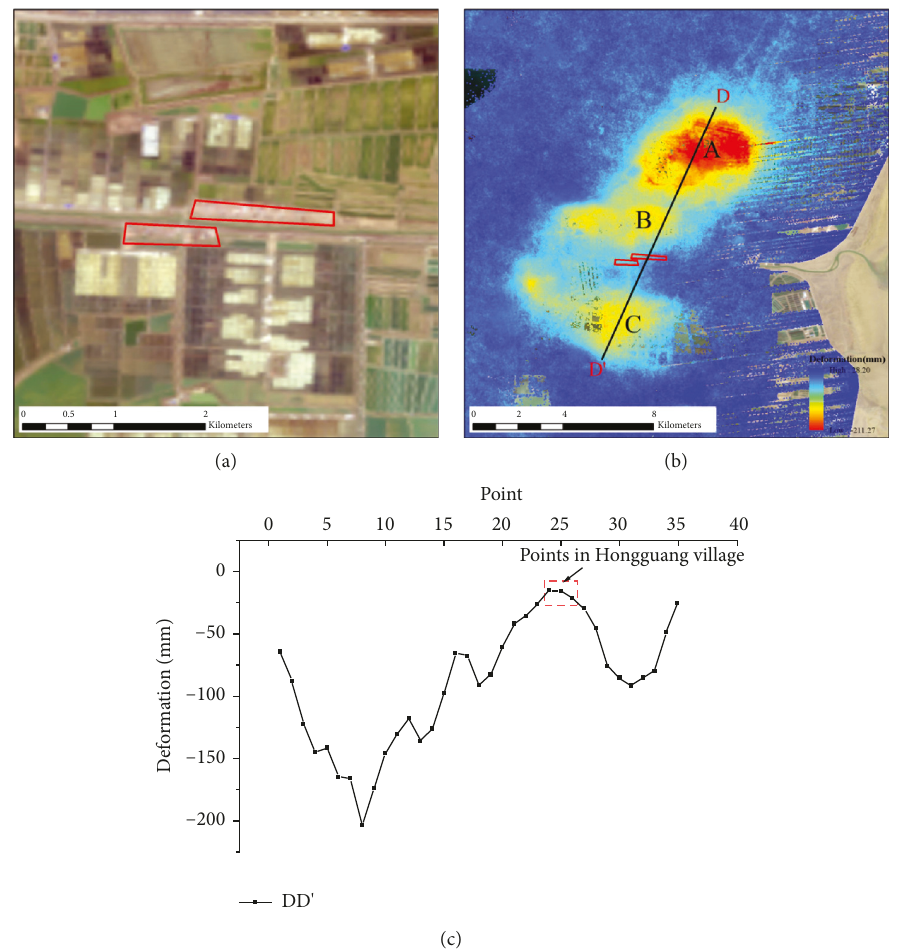
Figure 14: Subsidence analysis map of Hongguang village. (a) Enlarged landsat 8 image of Hongguang village, the buildings are marked by red line; (b) the enlarged cumulative map of subsidence. The three subsidence areas are marked with A , B , and C . The profile line is DD ′ . (c) Profile map. The location of the points in the building area is boxed on the